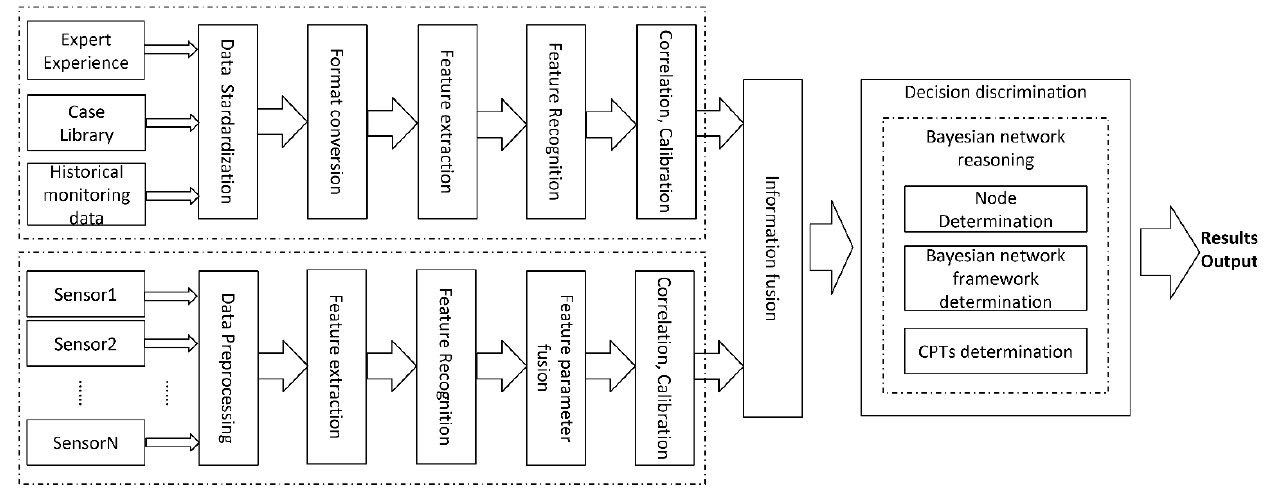
Figure 3. The multi-source information fusion fault diagnosis model.